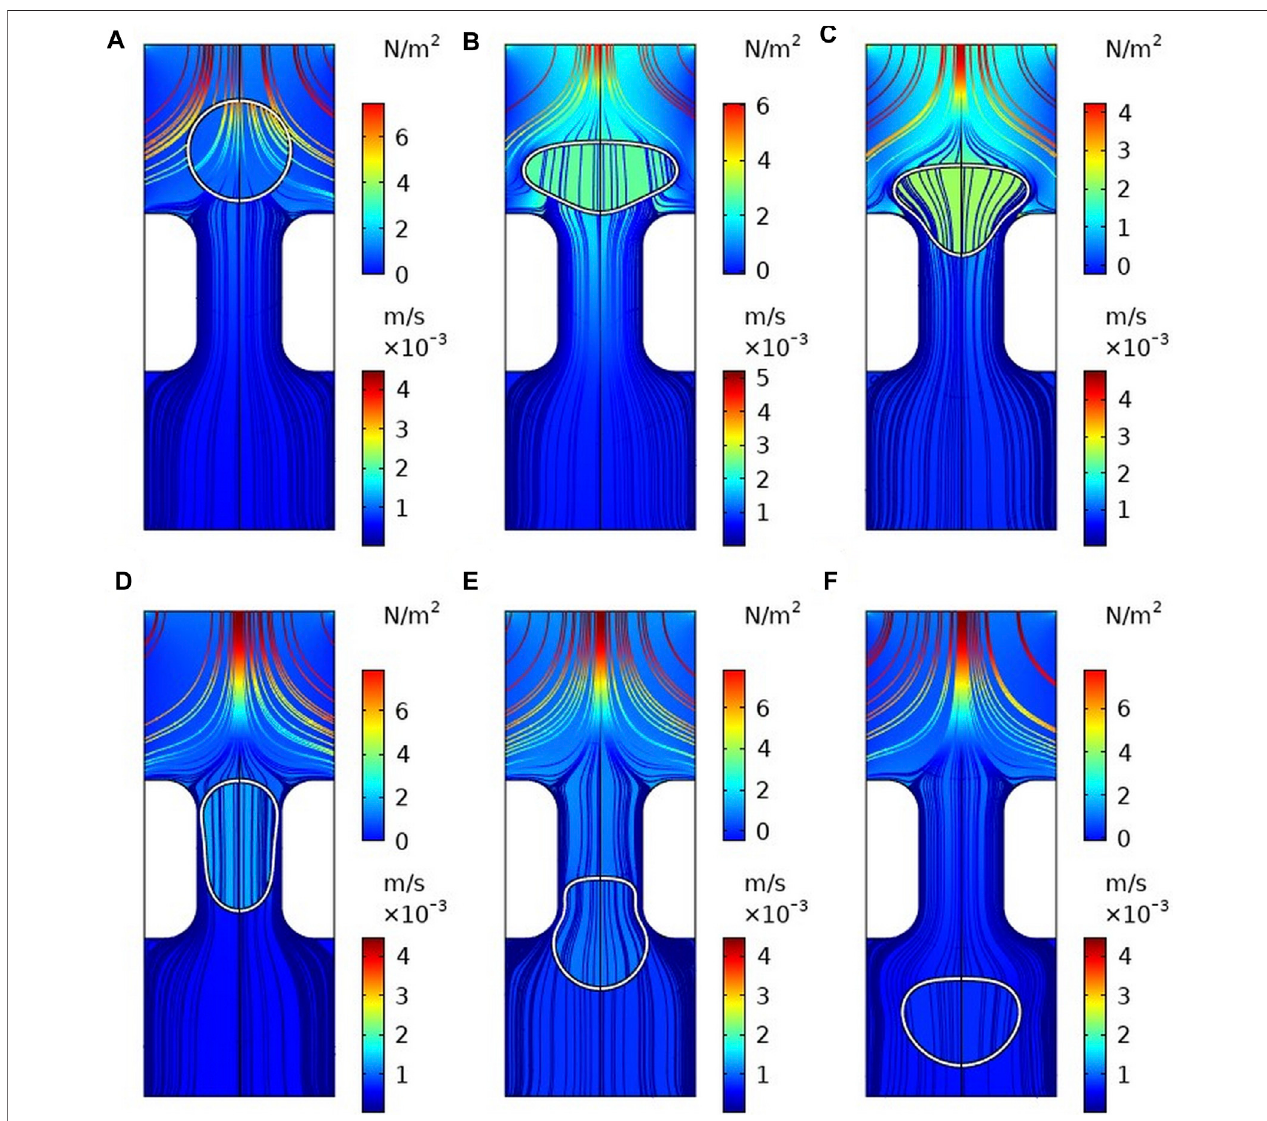
FIGURE 3 | Flow fi eld and pressure fi eld distribution during cell transmigration (A) t = 0 s; (B) t = 0.002 s; (C) t = 0.01 s; (D) t = 0.05 s; (E) t = 0.1 s; (F) t = 0.15 s.